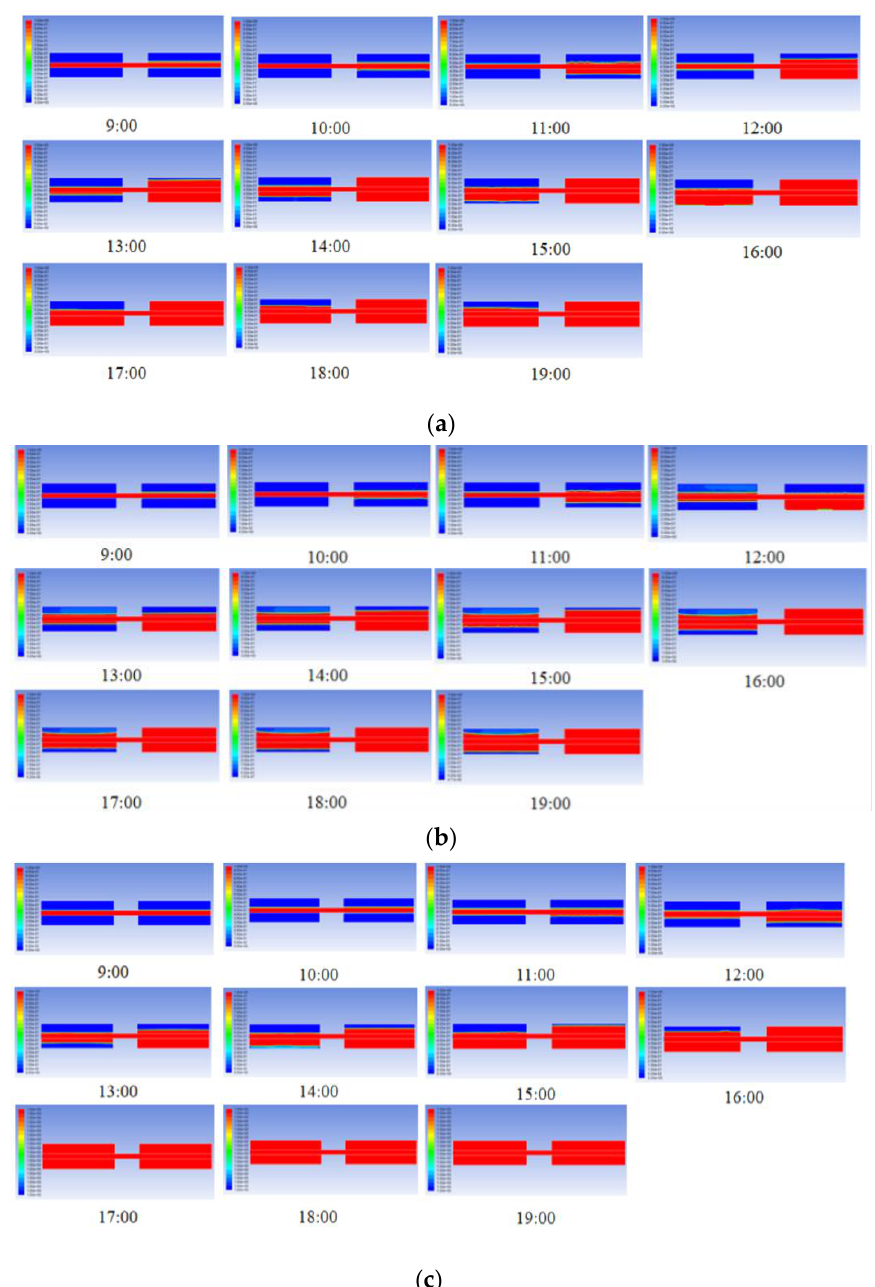
Figure 7. Heat storage behaviours in cascade units with three combination schemes of PCMs: ( a ) S1: stearic acid + lauric acid; ( b ) S2: paraffin (C28) + paraffin (C16); ( c ) S3: palmitic acid + polyethylene glycol.